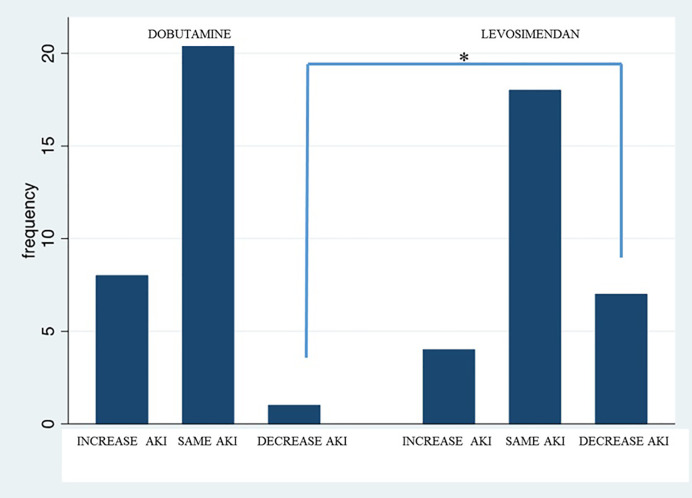
Variation of AKI stage after 24 h in patients treated with dobutamine vs. levosimendan. “*” statistically significant difference.